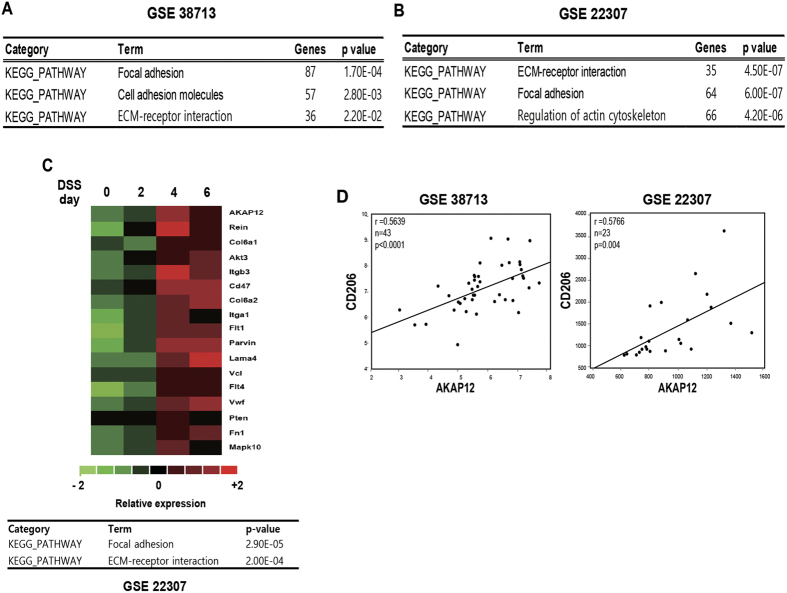
Bioinformatic approach showed the active alteration of mechanical environment in intestinal inflammation and the correlation of AKAP12 with that changes and CD206 expression.(A) KEGG pathway shows involvement pathway of differentially expressed genes (DEGs) between non-patients and ulcerative colitis patients (Total genes: 7045, p < 0.001). Analysis of DEGs was performed by GEO2R. (B) KEGG pathway shows involvement pathway of differentially expressed gene in DSS 0, 2, 4 and 6 day (Total genes: 3899, p < 0.001). Analysis of DEGs was performed by GEO2R. (C) Heatmap of gene expressions which is positive, none and negative correlated with AKAP12 expression in DSS 0, 2, 4 and 6 day of GEO dataset (GSE22307). (D) Heatmap of genes highly correlated with AKAP12 expression and involved in focal adhesion and ECM-receptor interaction in DSS induced colitis mice of GEO dataset (GSE22307). KEGG pathway shows involvement pathway of highly correlated genes with AKAP12 expression (Total genes: 418, r > 0.8 with AKAP12). (E) Scatter plots showing the correlation of AKAP12 expression with CD206 expression in a GEO dataset (GSE38713, GSE22307). The r value was calculated via Spearman’s rank correlation coefficient analysis.